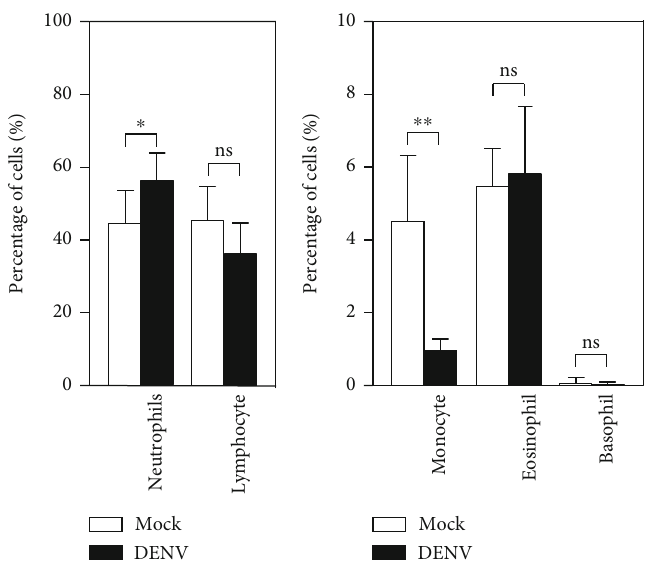
Figure 3: CBC results of whole blood (WB) cells 24 h postincubation. Following DENV ( MOI = 1 ) coculture in 100 μ l of WB ex vivo for 24 h, the CBC test showed the percentages of speci fi c cell populations as noted. The quantitative data are depicted as the mean ± SD obtained from fi ve cases. ∗ p < 0 : 05 and ∗∗ p < 0 : 01 , compared to the mock group. ns: not signi fi cant.